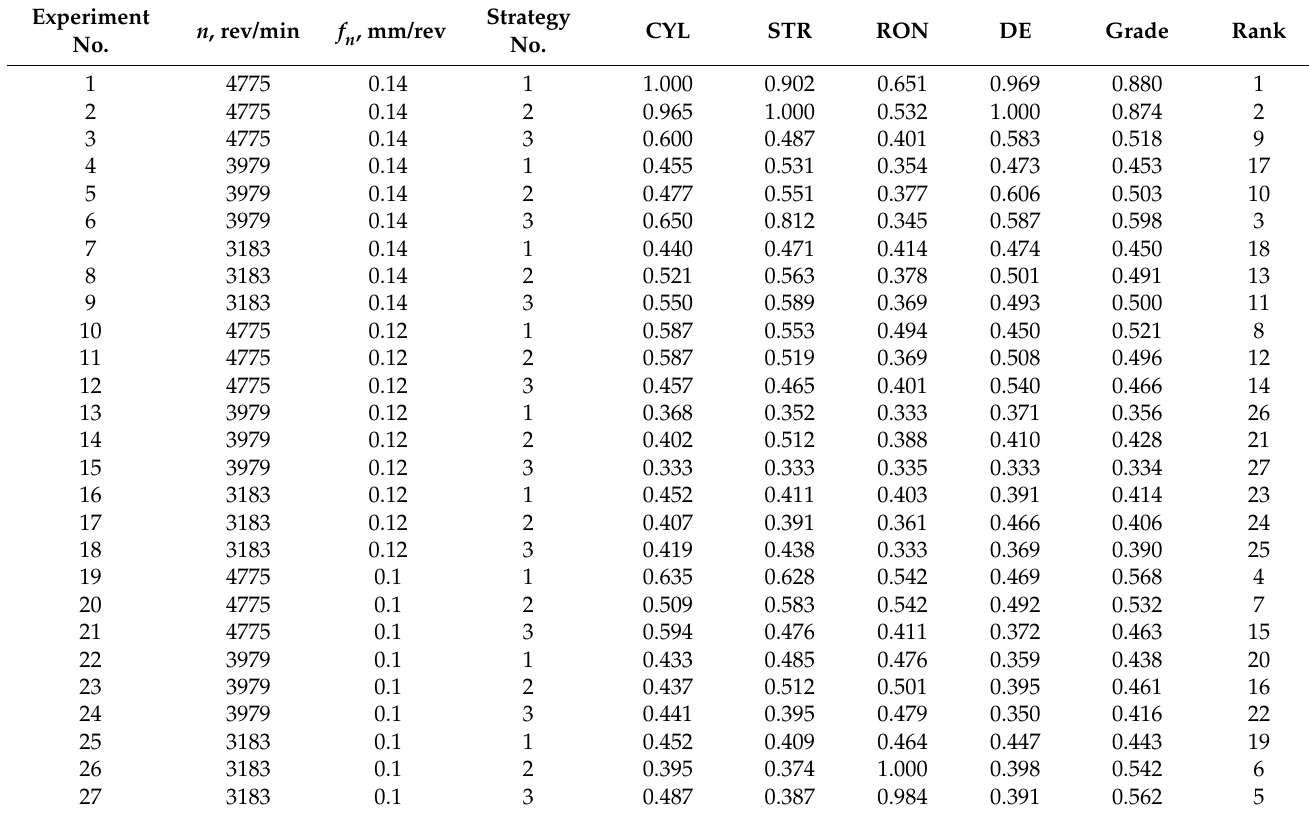
Table 5. Grey relational coefficients and Grey relational grade.